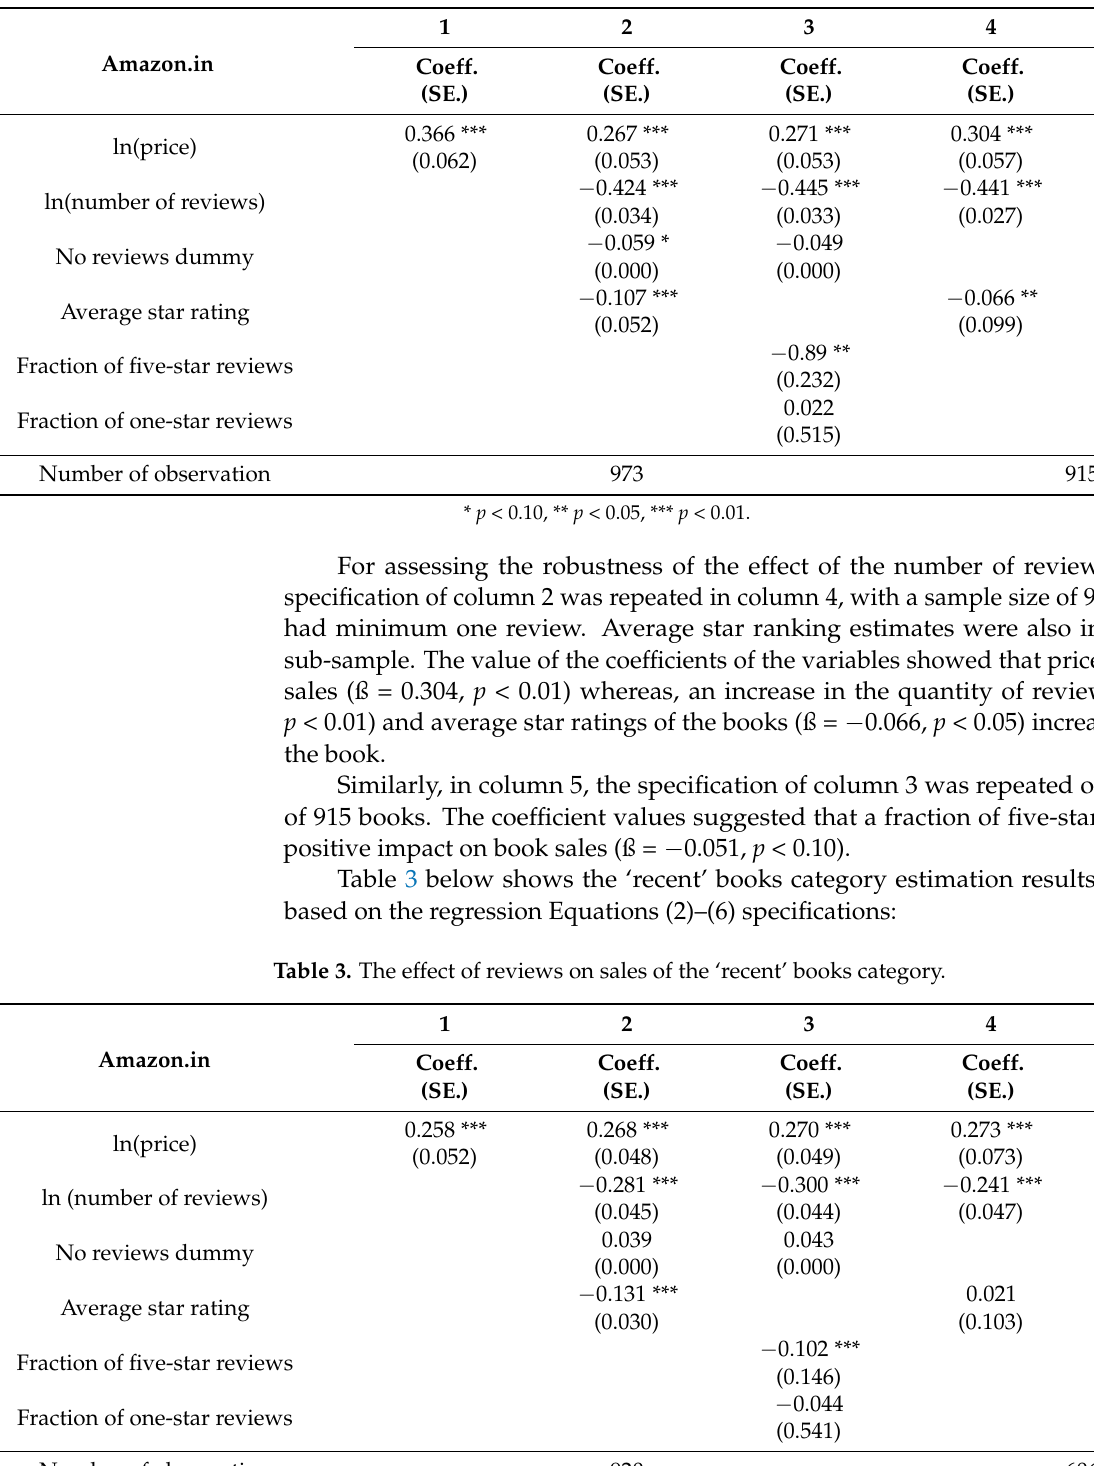
Table 2. The effect of reviews on sales of the ‘bestseller’ book category.